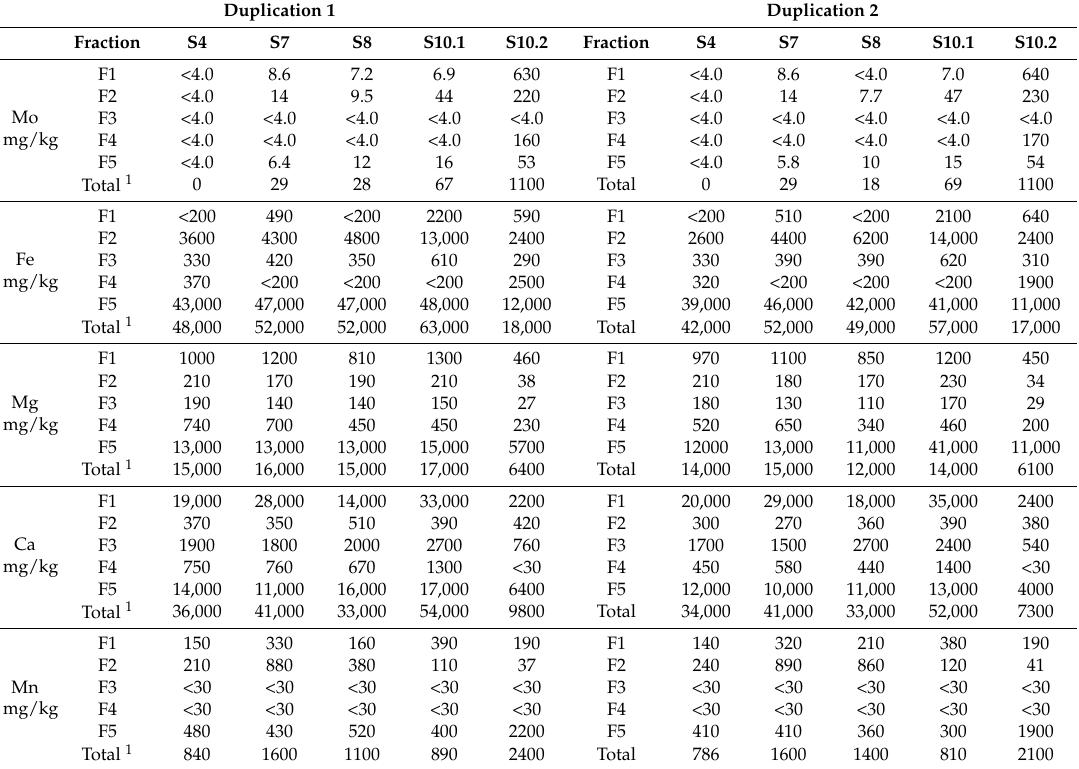
Table A1. Concentrations of respective elements in each fraction after sequential extraction.